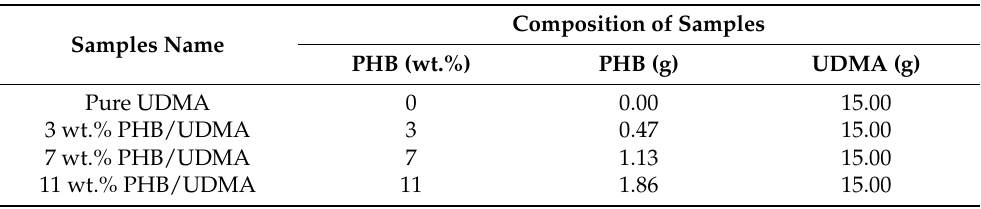
Table 1. Sample compositions of PHB/UDMA resin